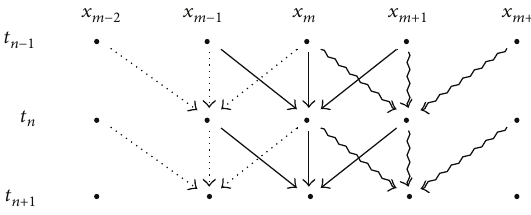
Figure 1: Discretization scheme of the diffusion